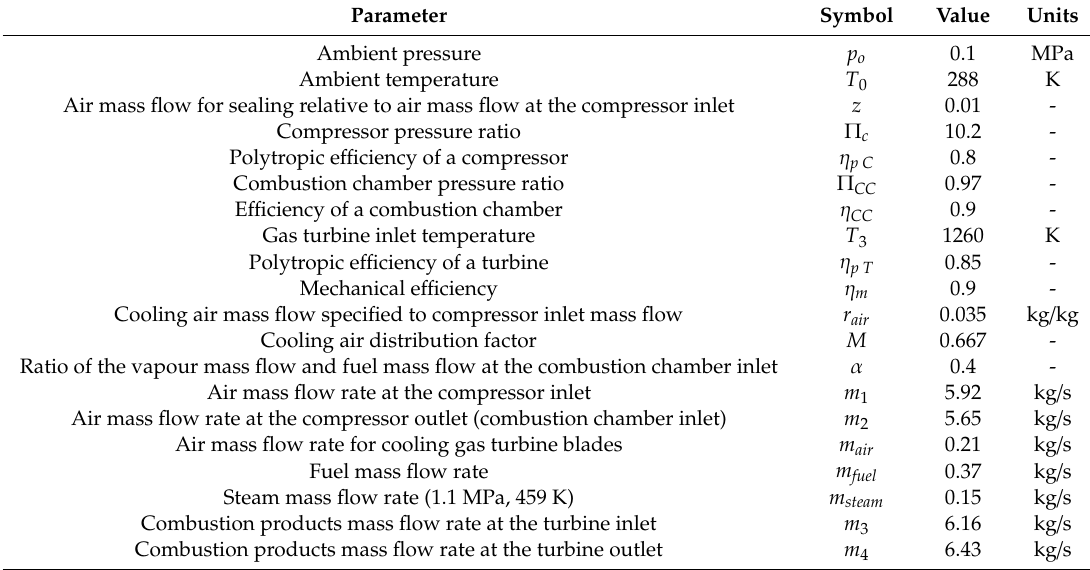
Table 1. Inlet parameters values for basic humidified Brayton cycle.